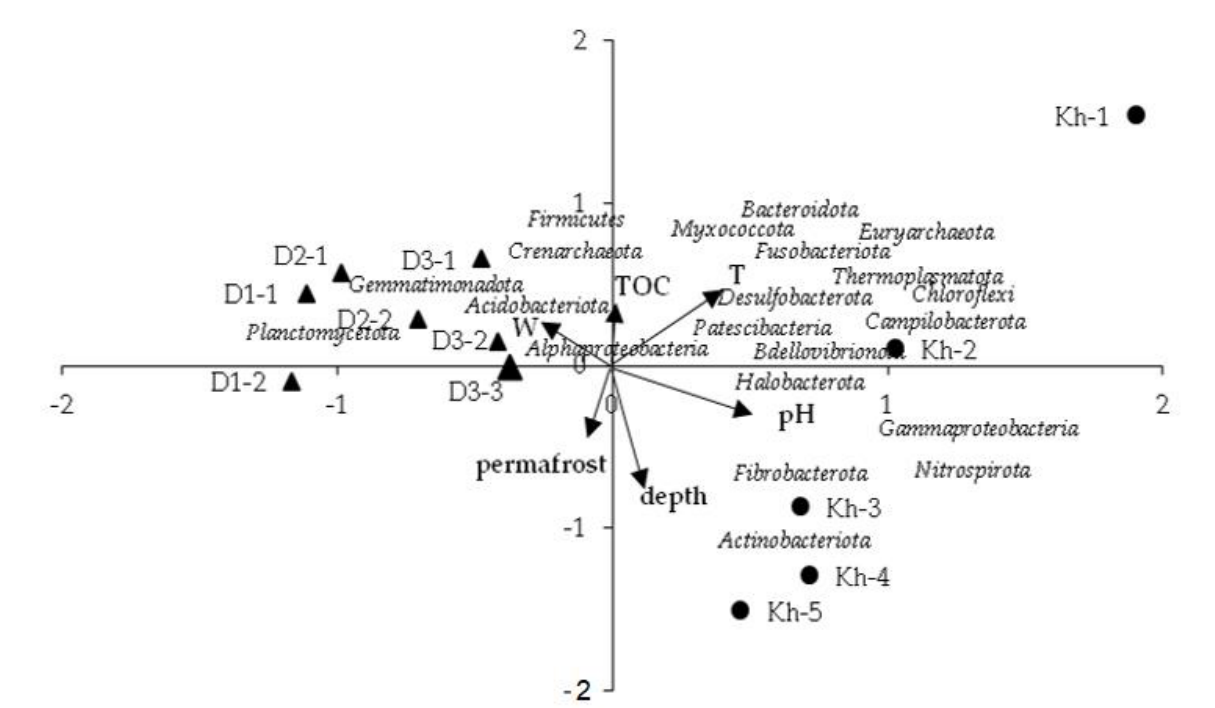
Figure 6. Canonical correspondence analysis (CCA) based on the microbial community structures and environmental factors (W − soil humidity, TOC − soil total carbon, T − soil temperature, permafrost—frozen layer: +1, or thawed layer: − 1).